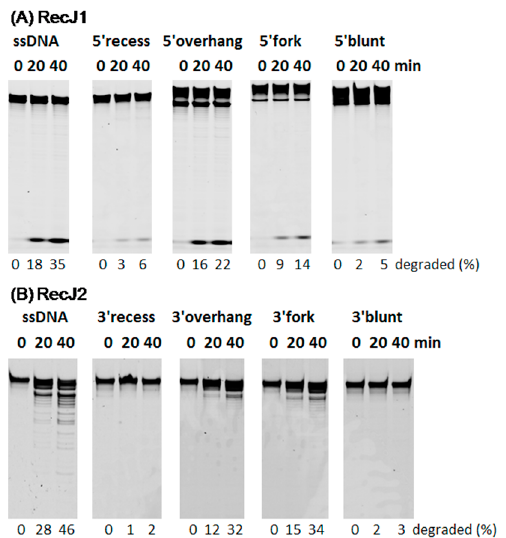
Figure 7. Selectivity of two MjaRecJs on DNA secondary structure. Two MjaRecJs (40 nM MjaRecJ1 or 50 nM MjaRecJ2) were incubated with 200 nM DNA substrates at 55 °C for 0, 20, and 40 min in their respective reaction buffer. DNA secondary structures are single-stranded, forked, overhanged, recessed, and blunt. The degraded amount of substrate DNA was quantified at each time and listed at the bottom of the panel.